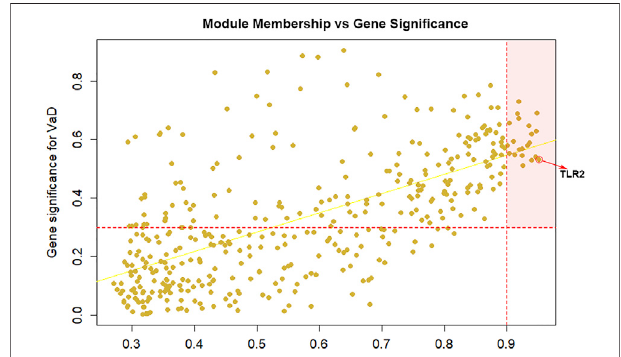
FIGURE 2 | Selection of hub genes. Module membership (MM) vs. gene signi fi cance (GS) in the yellow module (correlation coef fi cient = 0.65, *** p < 0.001).Thereddottedlinesrepresented thethresholdsofMM > 0.9andGS >